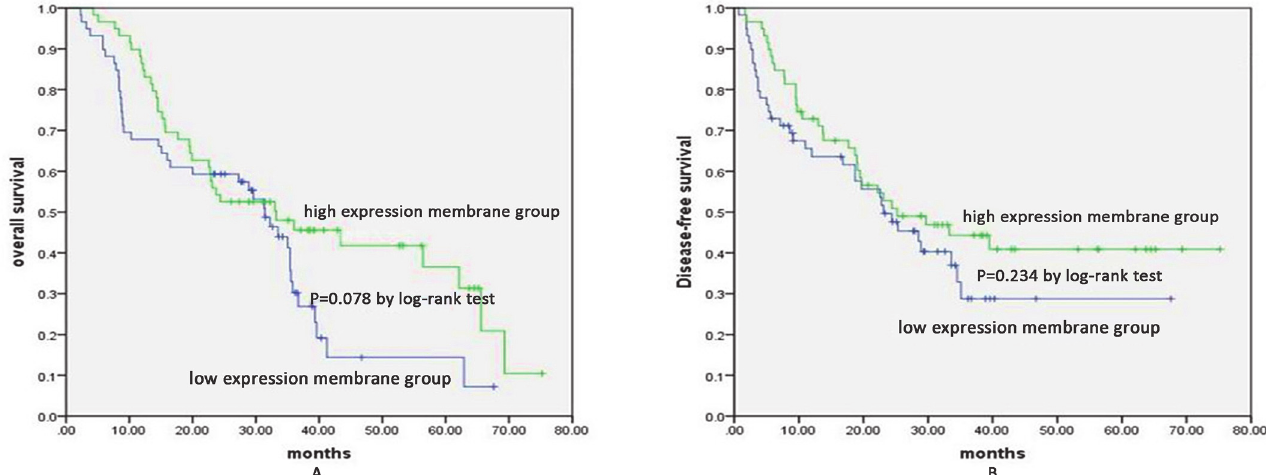
Fig 2. Kaplan-Meier estimates of the OS and DFS according to membrane expression in ESCC patients. A. Kaplan-Meier curves illustrating the OS of the high membrane expression group versus the low membrane expression group. Five-year OS of the high membrane expression group (36.6%) versus the low membrane expression group (14.4%), P = 0.078; B. Kaplan-Meier curves illustrating the DFS of the high membrane expression group versus the low membrane expression group. Five-year DFS of the high membrane expression group (40.9%) versus the low membrane expression group (28.7%), P =